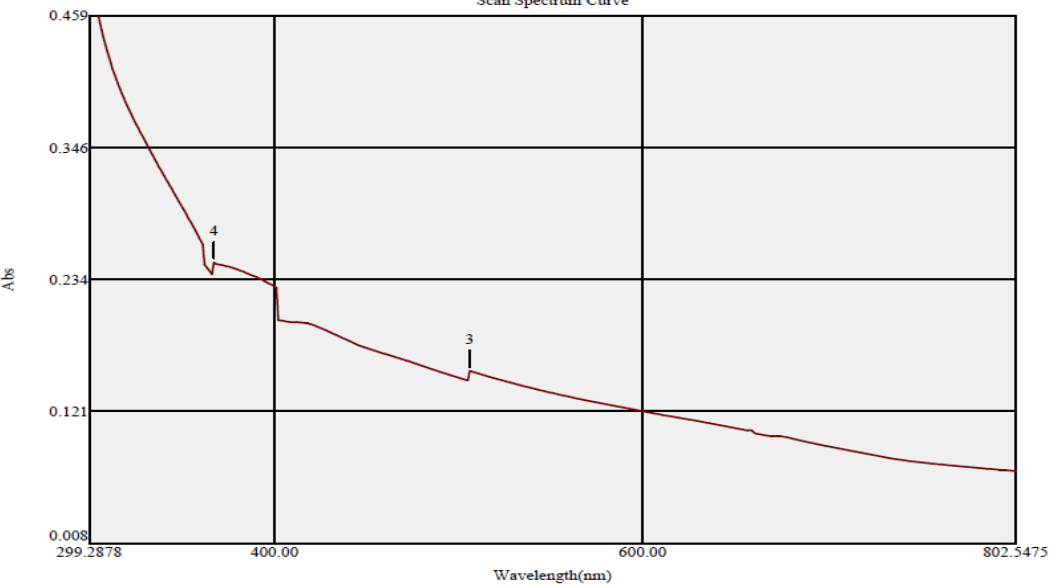
Figure 2. UV-vis spectrum of zinc oxide nanoparticles synthesized using aqueous pomegranate extract (Peak 3: 506 nm; Peak 4: 367 nm).